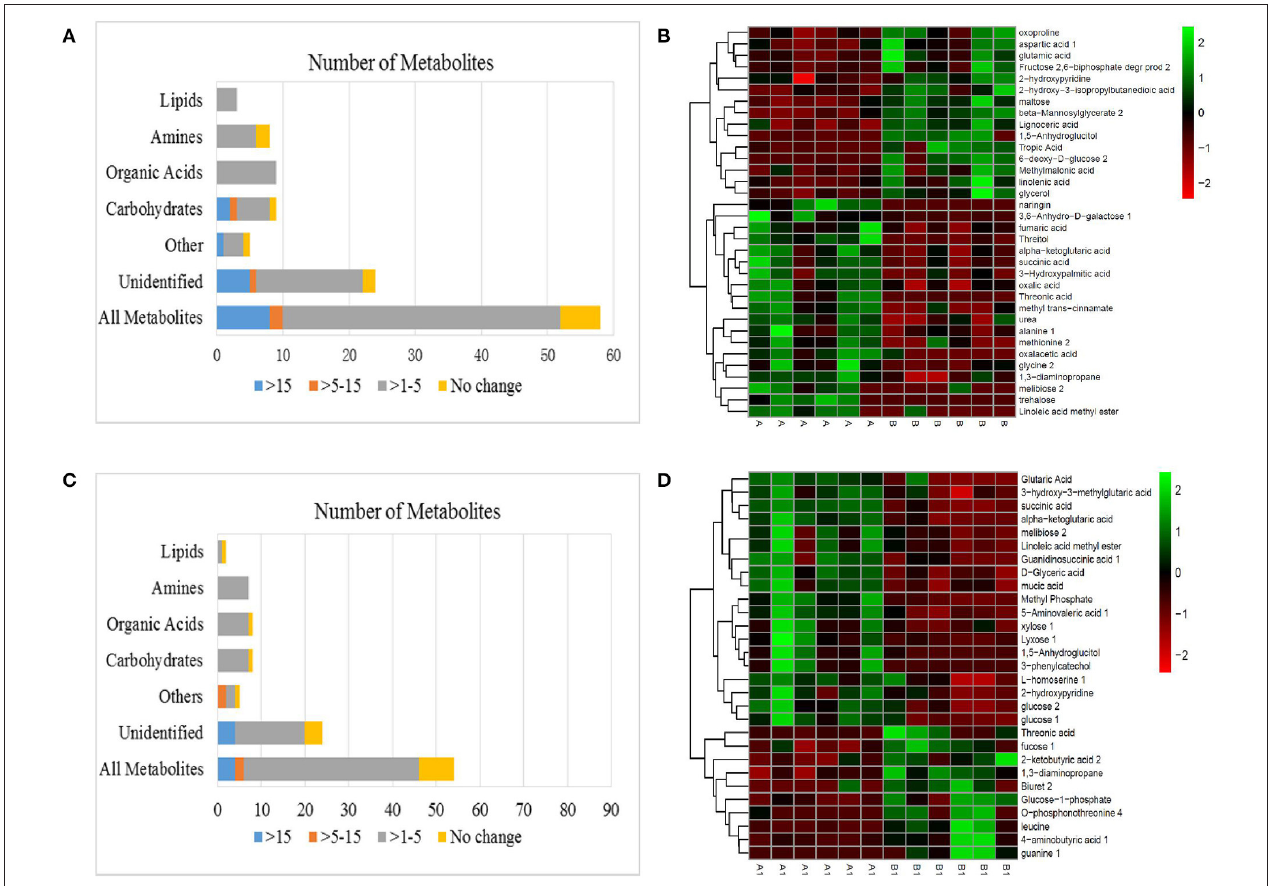
FIGURE 6 | (A) Effects of metabolomes in NI and RI alfalfa. (B) Heat map analysis combined with hierarchical cluster analysis of A and B. (C) Effects of alkali stress on the metabolomes of NI and RI. (D) Heat map analysis combined with hierarchical cluster analysis of A1 and B1. A, NI control; B, RI control; A1, NI 6 d after alkali stress; B1, RI 6 d after alkali